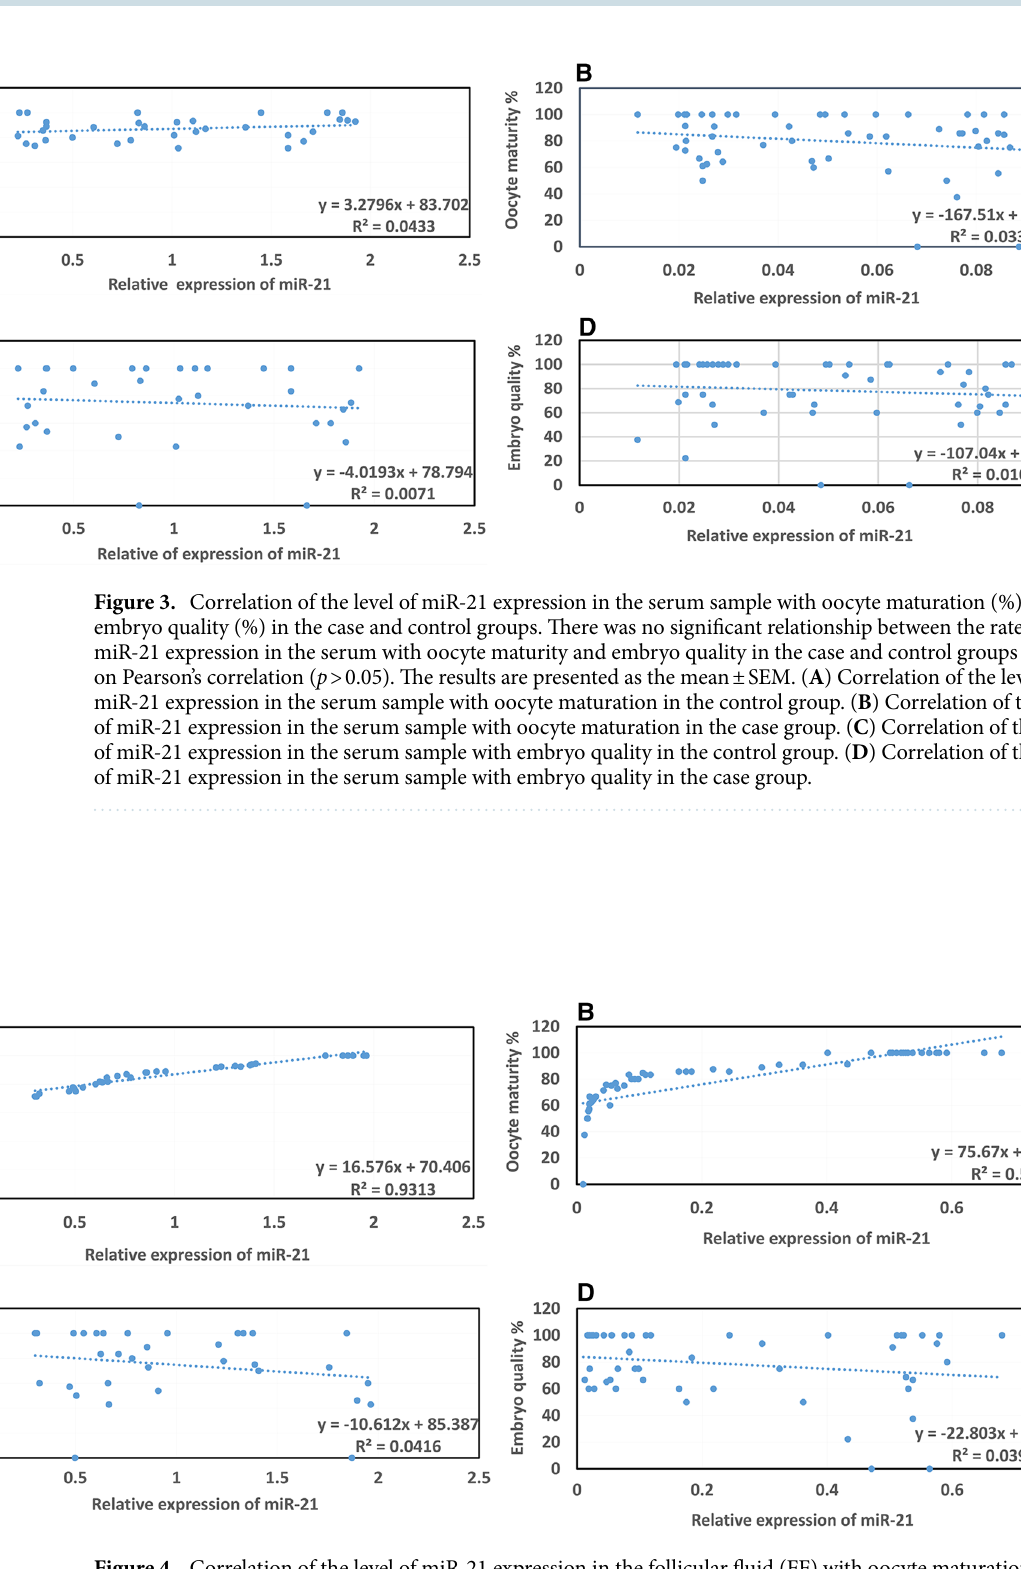
Figure 4. Correlation of the level of miR-21 expression in the follicular fluid (FF) with oocyte maturation (%) and embryo quality (%) in the case and control groups. The rate of miR-21 expression in the FF environments was directly related to the oocyte maturation in both groups based on Pearson’s correlation ( p < 0.05). There was no significant relationship between the rates of miR-21 expression in the FF and embryo quality based on Pearson’s correlation ( p > 0.05). The results are presented as the mean ± SEM. ( A ) Correlation of the level of miR-21 expression in the FF sample with oocyte maturation in the control group. ( B ) Correlation of the level of miR-21 expression in the FF sample with oocyte maturation in the case group. ( C ) Correlation of the level of miR-21 expression in the FF sample with embryo quality in the control group. ( D ) Correlation of the level of miR-21 expression in the FF sample with embryo quality in the case